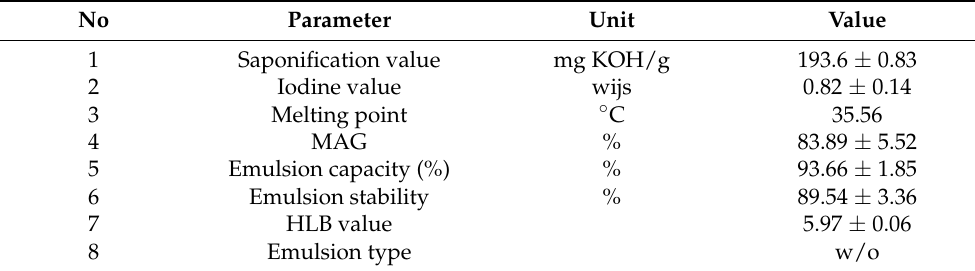
Table 1. Physicochemical and emulsifying properties of